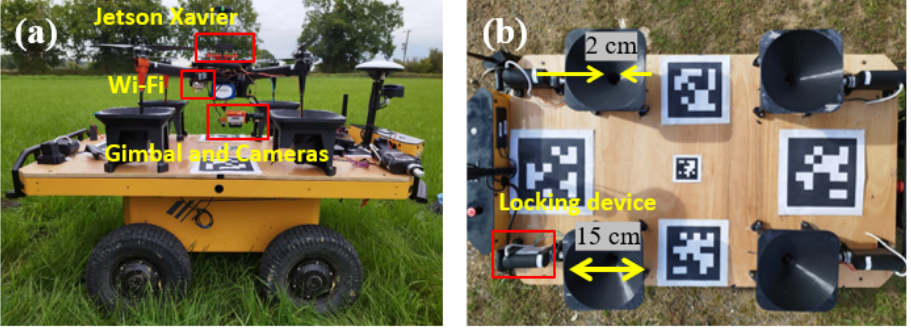
Figure 1. The structure and hardware configuration of the designed platform: ( a ) Side view of the UAV docked on the UGVs; ( b ) Top view of the layout of the docking platform with its critical